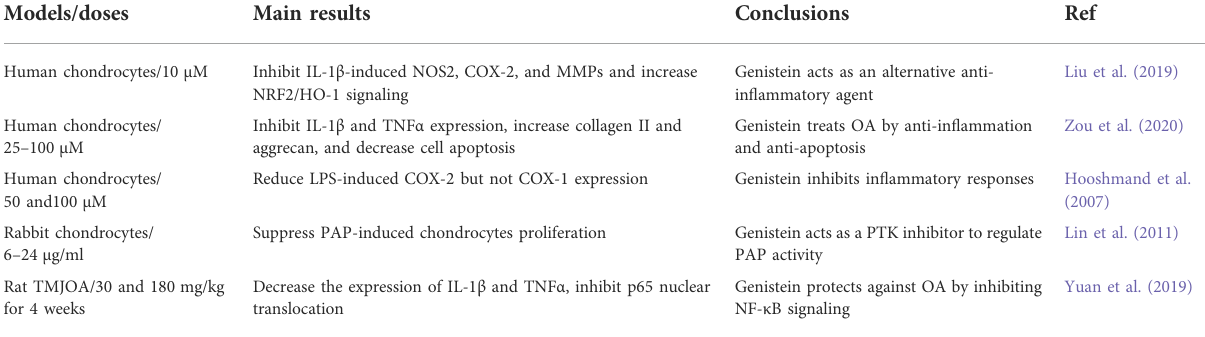
TABLE 2 The biological effects of genistein on